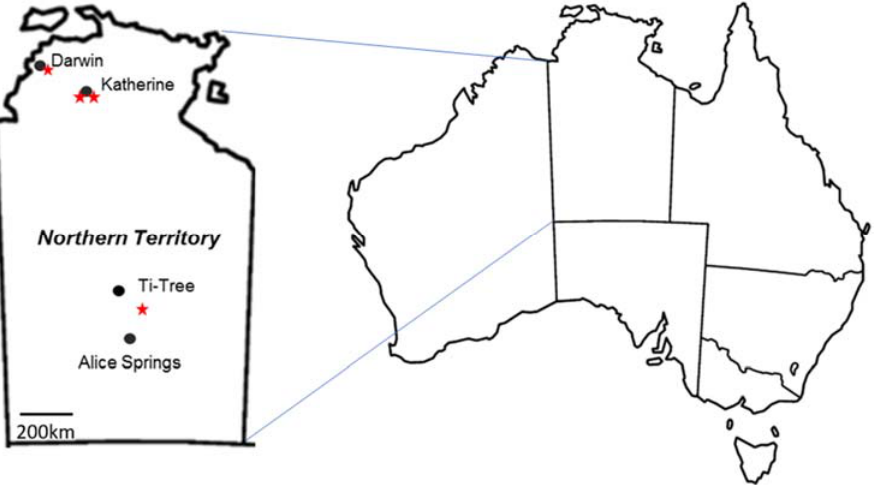
Figure 3. The location (red star) of the four filed trial sites spread out across the Northern Territory.